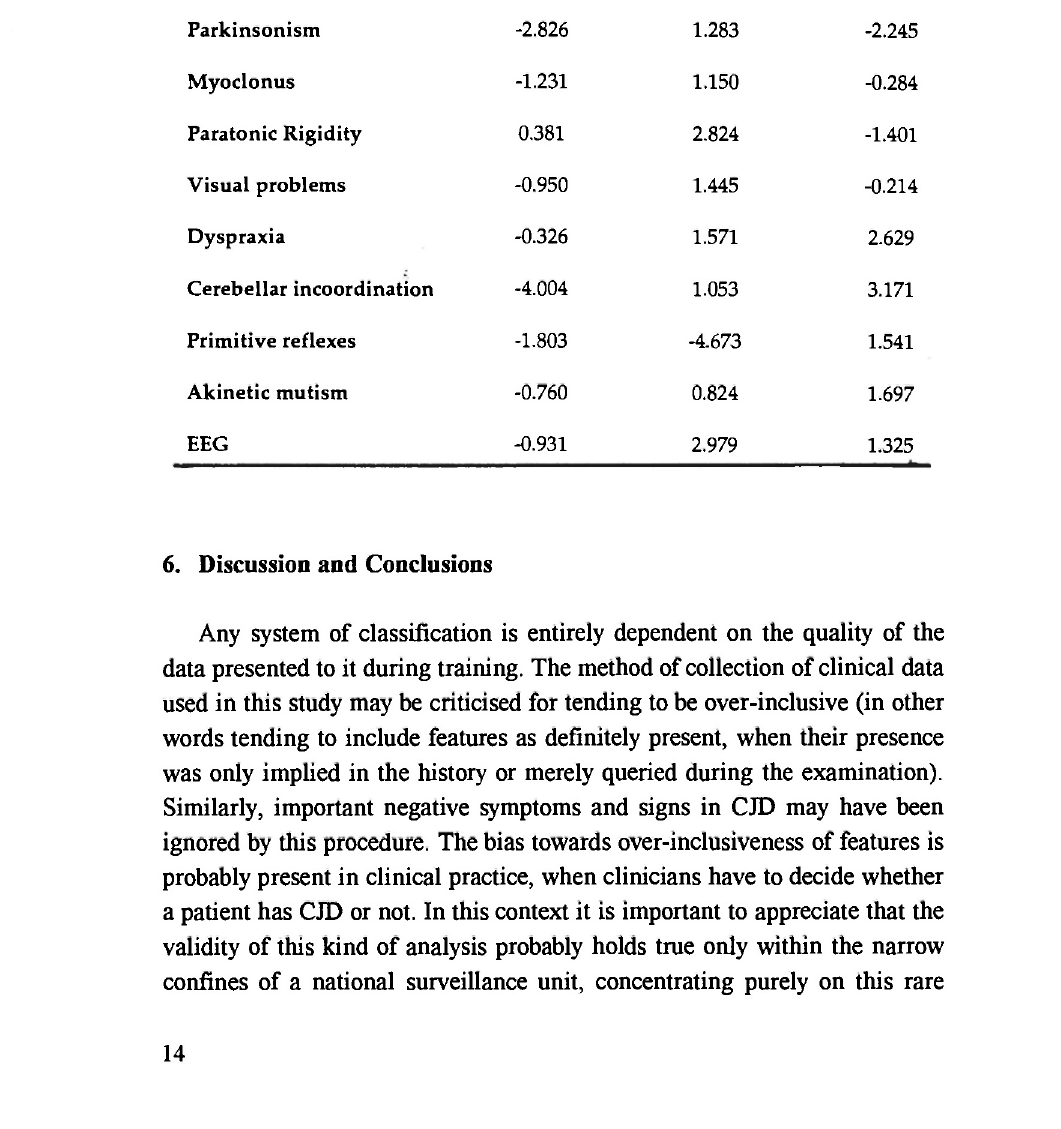
Numerical values of the trained MLP's connection weights shown for all three hidden neurons (HN) to the twelve input